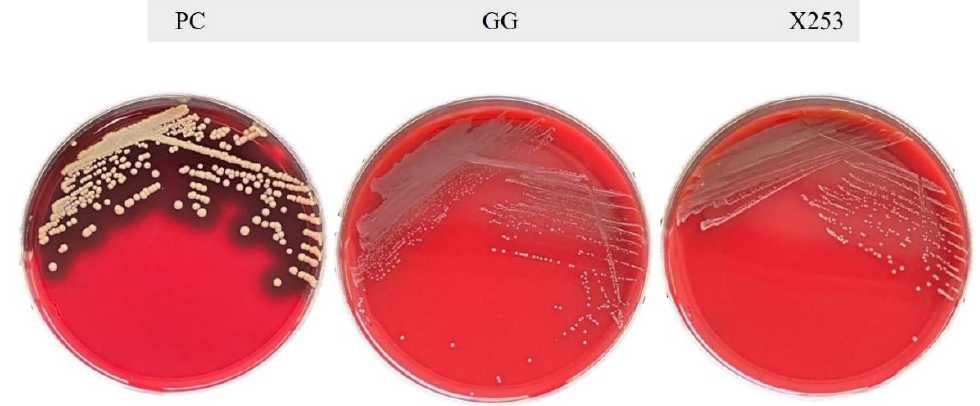
Figure 3. Hemolytic ability of L. rhamnosus GG and X253: As a positive control, S. aureus ATCC 6538 generated a clearly visible zone of β -hemolytic activity.